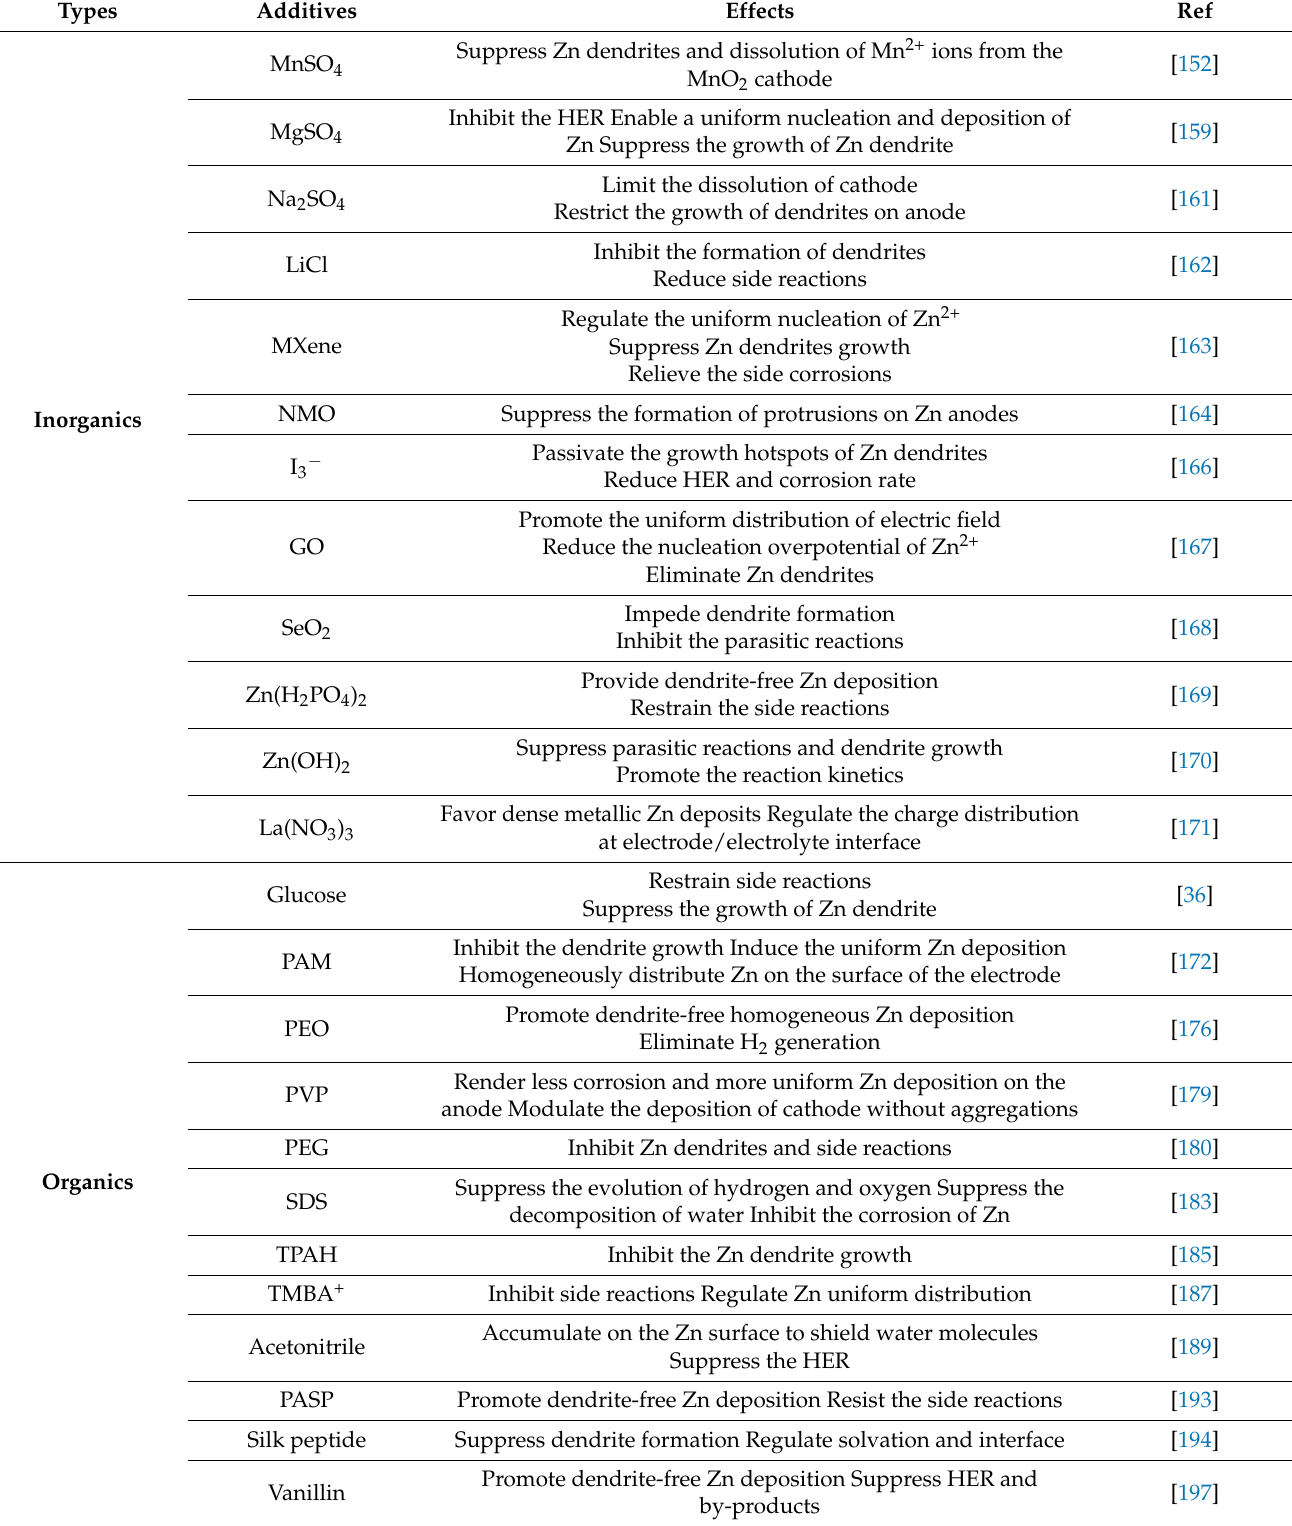
Table 5. Summary of previously reported electrolyte additives and their effects in